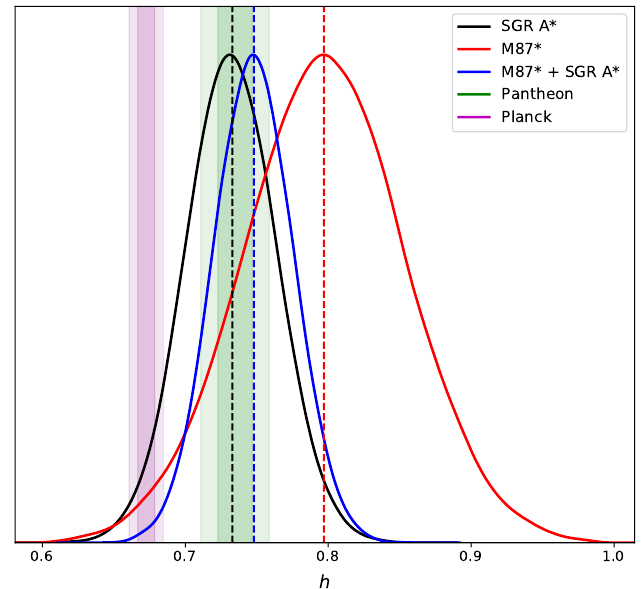
Figure 4. Reduced Hubble constant h = H 0 /100 [km/s/Mpc] determined by our analysis using the SMBH shadows from M87* and Sgr A* combined observations at low redshift (blue color). Each individual posterior for M87* (red color) and Sgr A* (black color) are also showed. Vertical bands show the constraints at 1 σ for the Pantheon SNIa catalog (green color) and the Planck Collaboration (purple color). The vertical dashed lines indicate the mean value for h